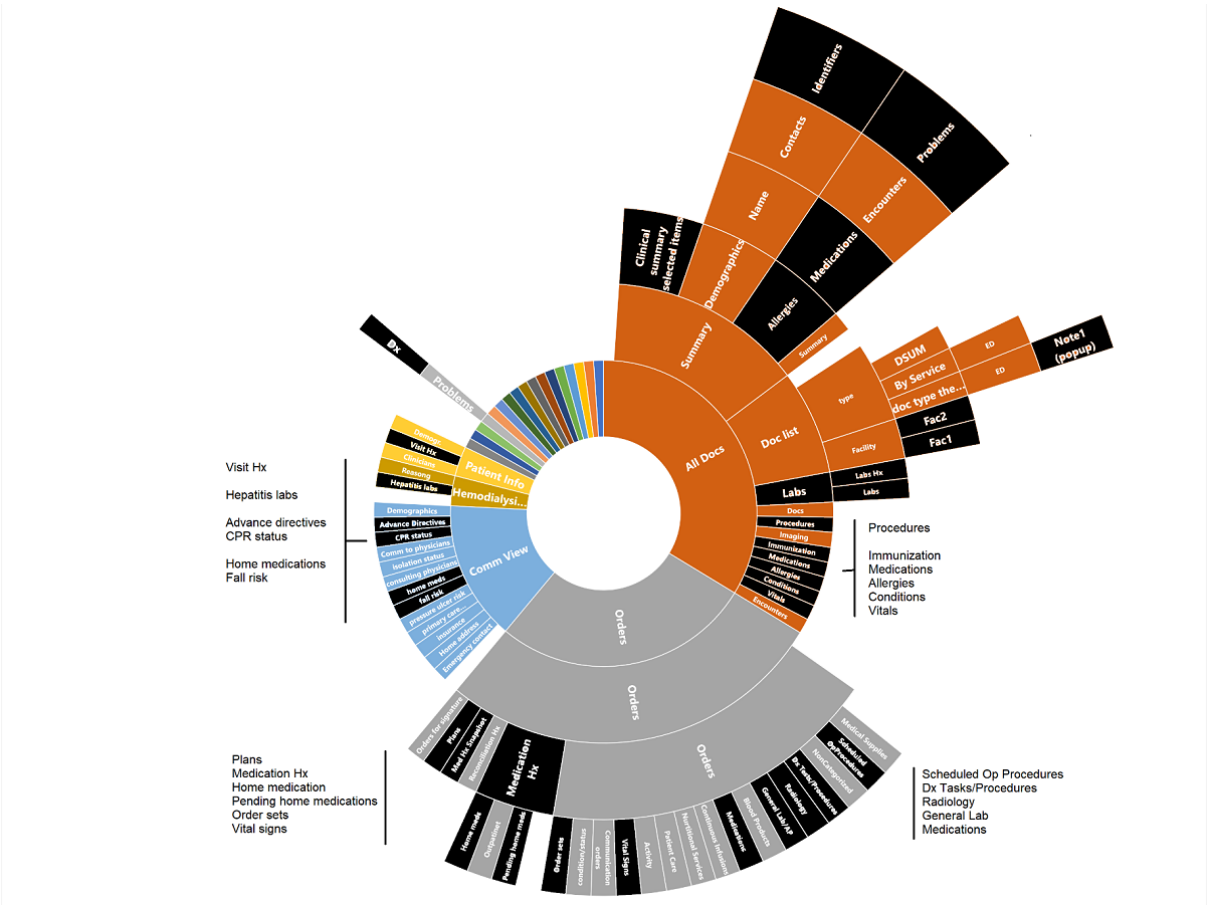
Figure 5. Sunburst diagram representing display fragmentation of clinical data in a conventional, commercial electronic health record. Elements colored in black are those relevant for handling the clinical problem (general review of patient information). EHR: electronic health record; UI: user